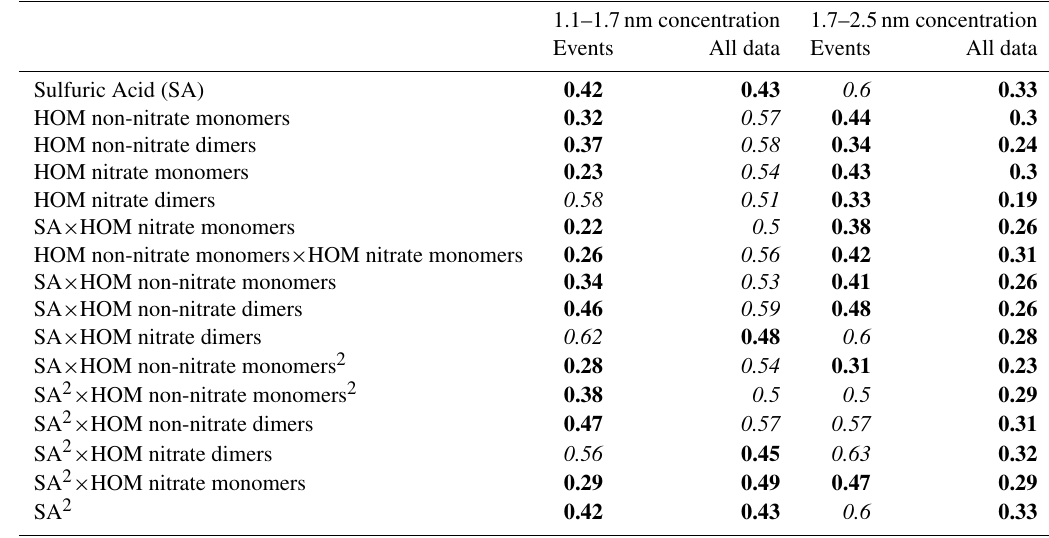
Table 3. Logarithmic Pearson correlations between particle concentrations in different size bins measured with the PSM and known pre- cursor vapors or combinations of precursor vapors. The data from NPF events occurring between 10:00 and 14:00LT are used. Statistically significant values ( p < 0 . 05) are bolded, and values higher than 0.5 are highlighted in italics.